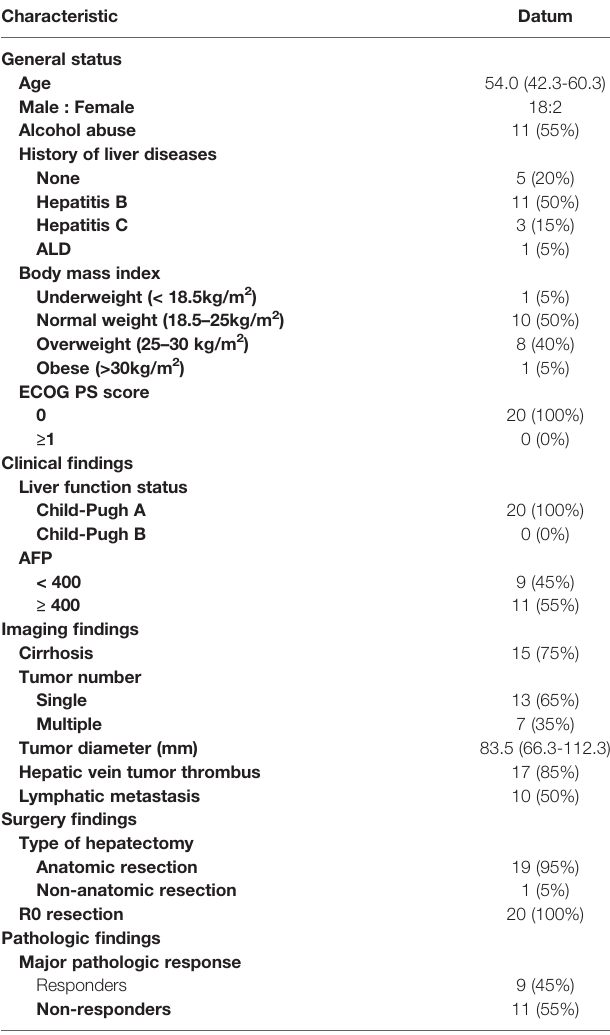
TABLE 1 | Baseline Clinical and Pathologic